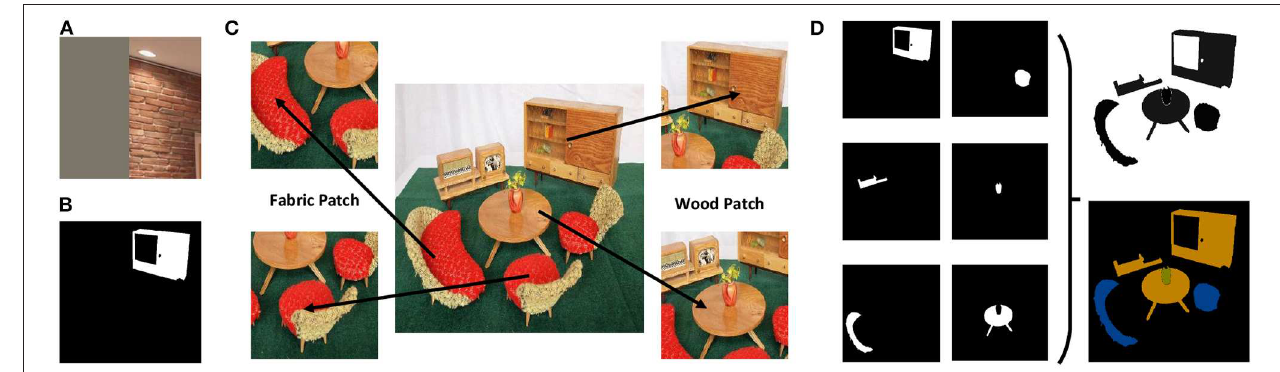
FIGURE 3 | Data preprocessing. (A) A patch with NaN values in MINC. (B) A partially pixel-wise labeled image in MINC. (C) Extracting new patches from original images in MINC. (D) Combining the partially pixel-wise labeled images to generate a fully pixel-wise labeled